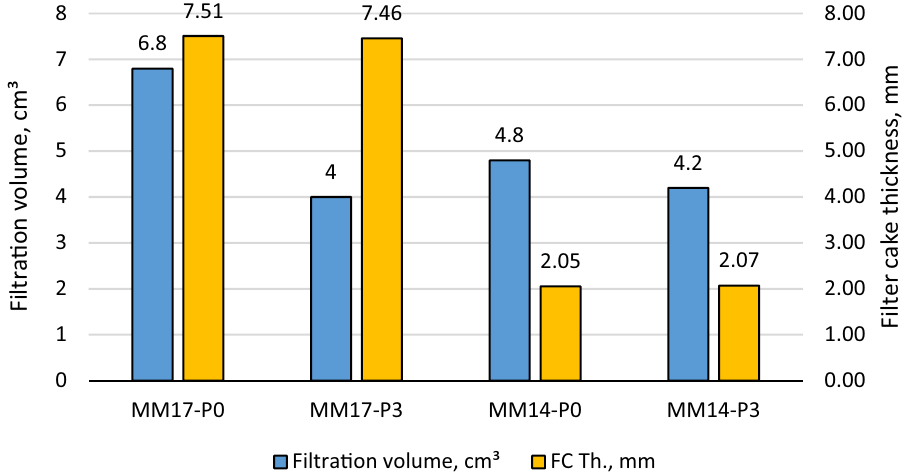
Figure 9. Filter cake thickness and filtration volume as function of perlite for mud samples with perlite concentrations equal to 0 and 3 lb/bbl.